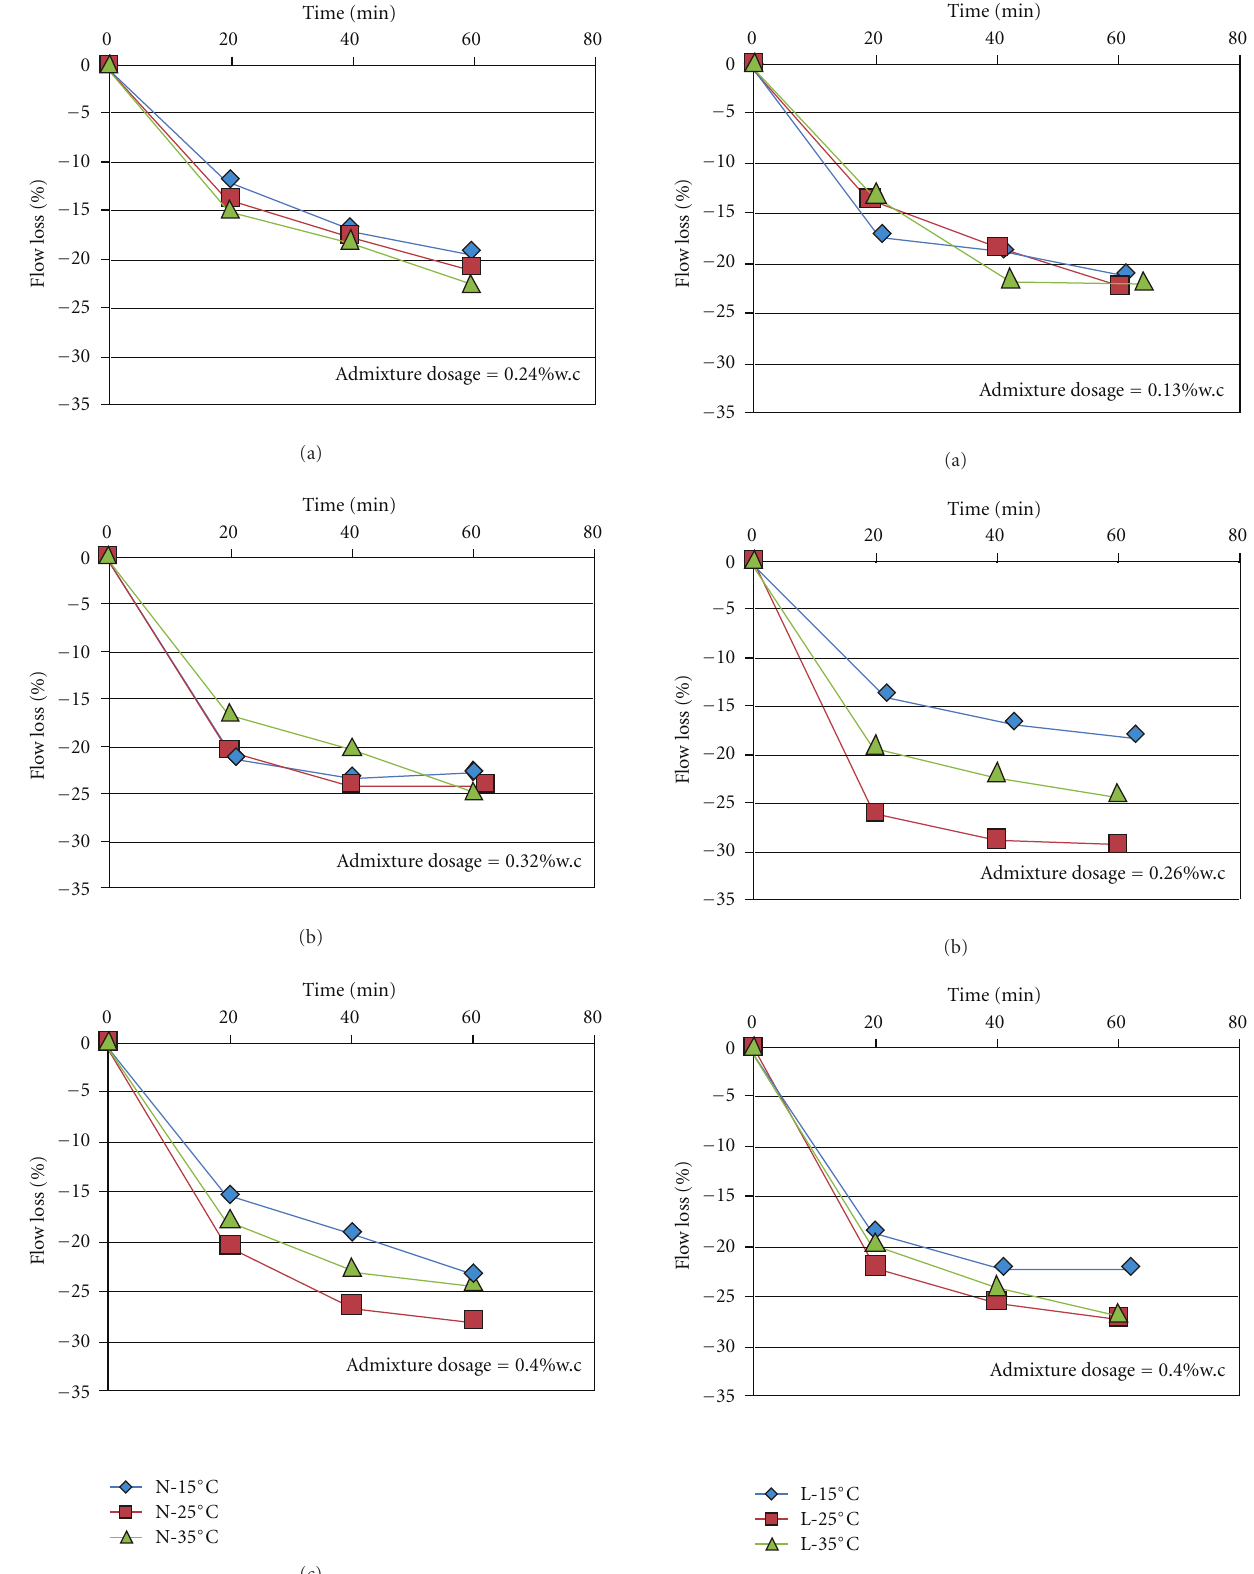
Figure 7: E ff ect of temperature variation on flow loss—naphtha- lene